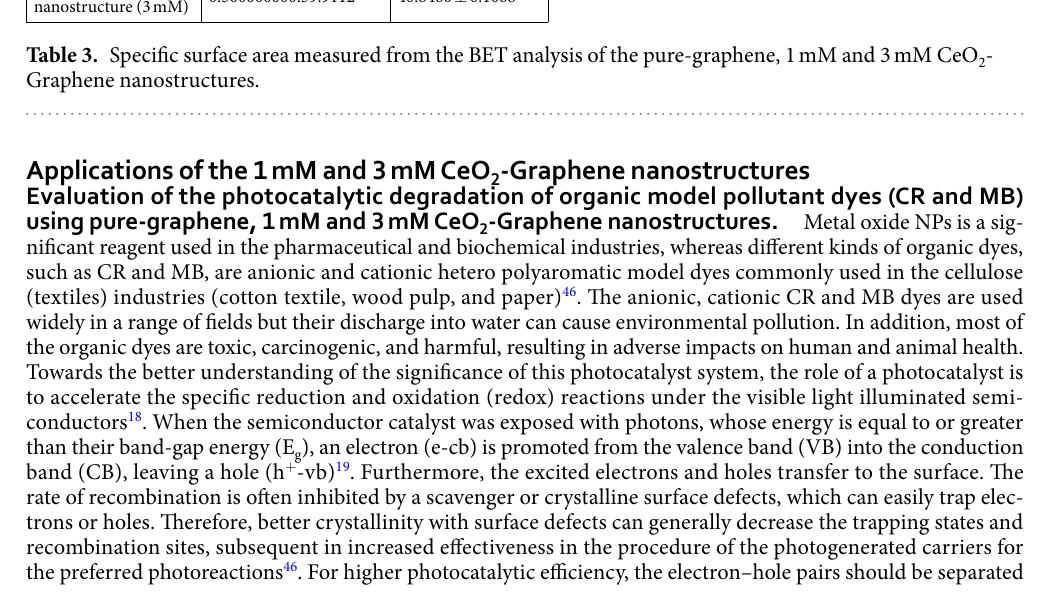
Table 3. Specific surface area measured from the BET analysis of the pure-graphene, 1 mM and 3 mM CeO 2 - Graphene